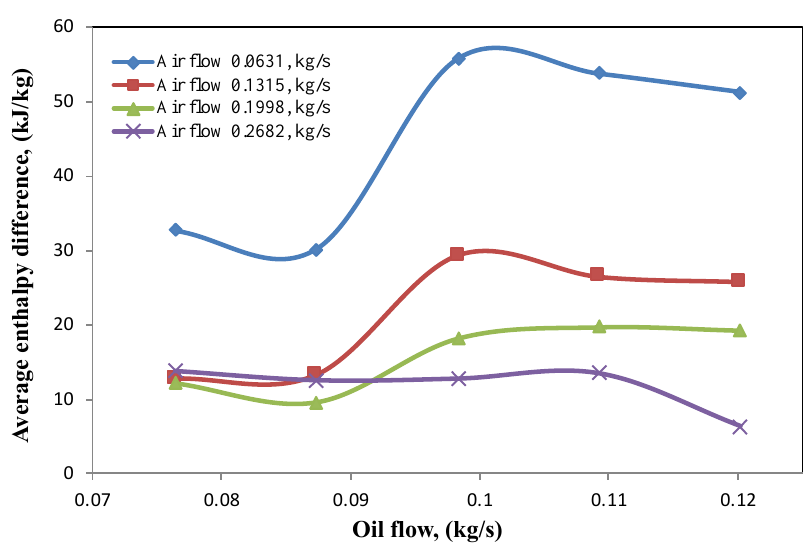
Figure 17. Average enthalpy difference at different air and oil flow rates.